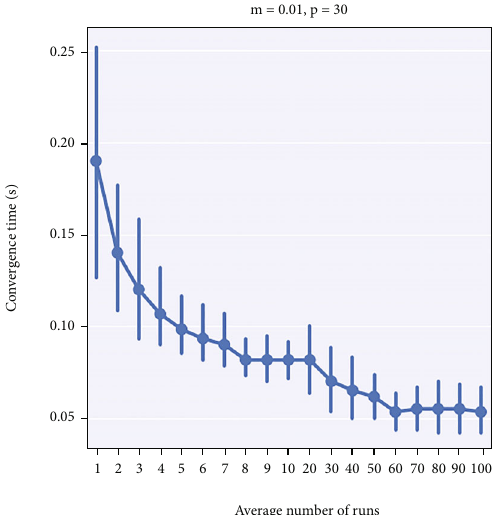
Figure 10: Categorical plot of convergence of algorithm for a mutation rate ( m ) of 0.01 for populations ( p ) of